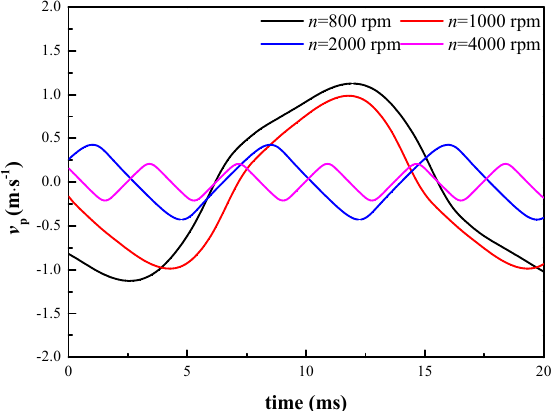
Figure 11. Velocities of different valve spool rotation speeds when the supply pressure is 4 MPa.